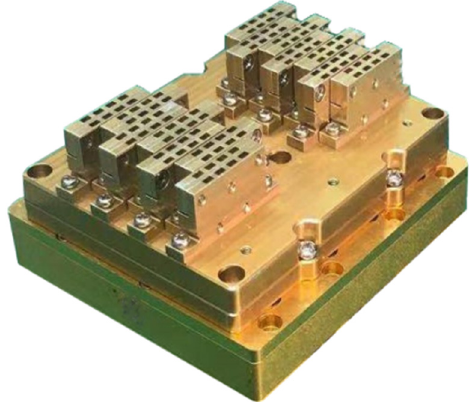
Figure 11. The W-Band active phased array antenna.